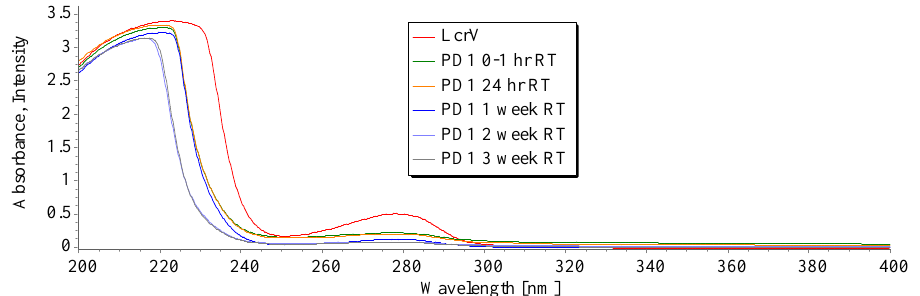
Figure 2. UV–Visible spectra of LcrV and PD1 formulation (at different storage intervals).